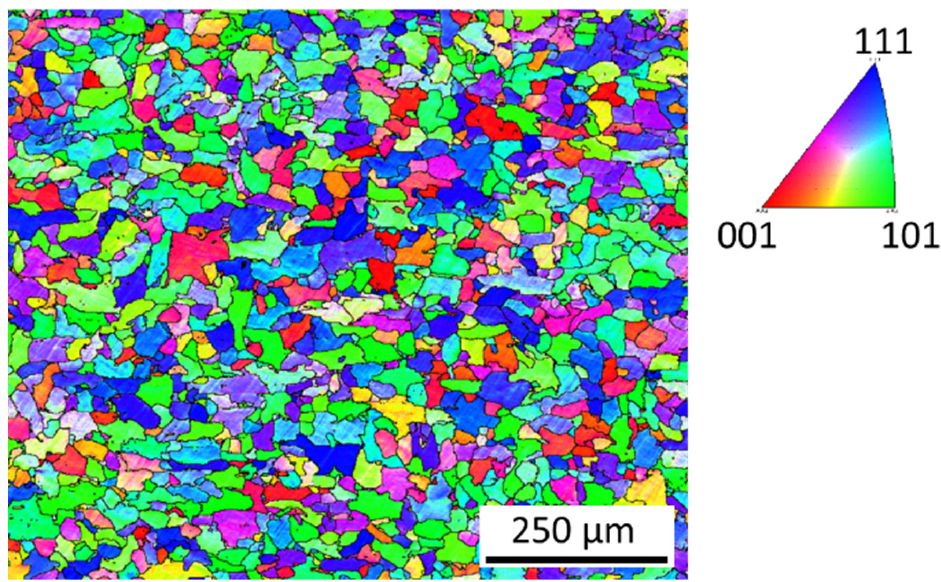
Figure 6. Inverse pole figure (IPF) map of the AISI 1020 base metal.